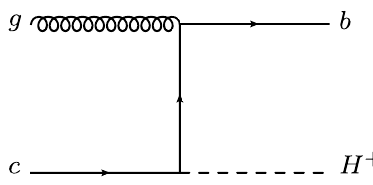
Figure 7 . Charged Higgs production through gc fusion contributing to pp → bH ±